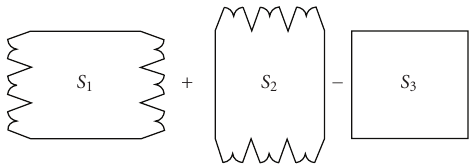
Figure 2: Decomposition of aperture S into three parts S 1 , S 2 , and S 3 .